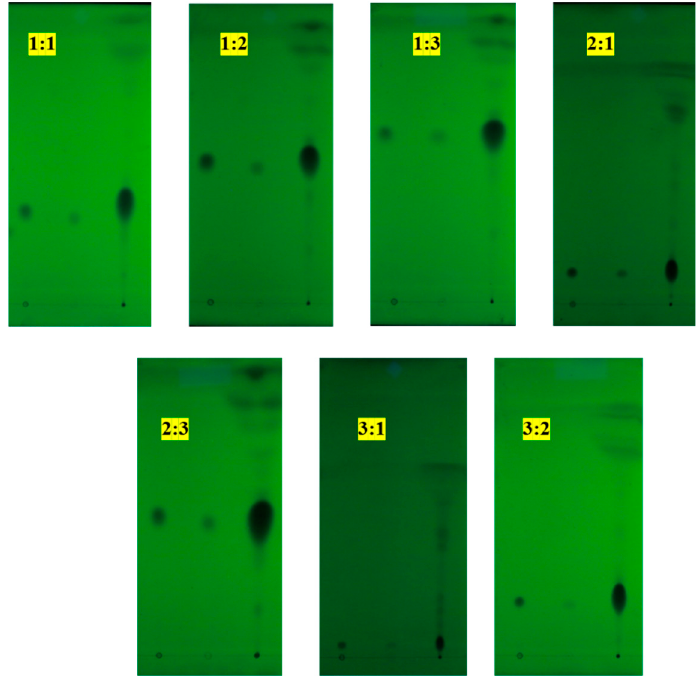
Figure 1. Seven different solvent systems in TLC (the sample points in all TLC plates, from left to right, are standard hydroxyl- α -sanshool and PEE, respectively). Table 1. Rf of hydroxyl- α -sanshool in different solvent